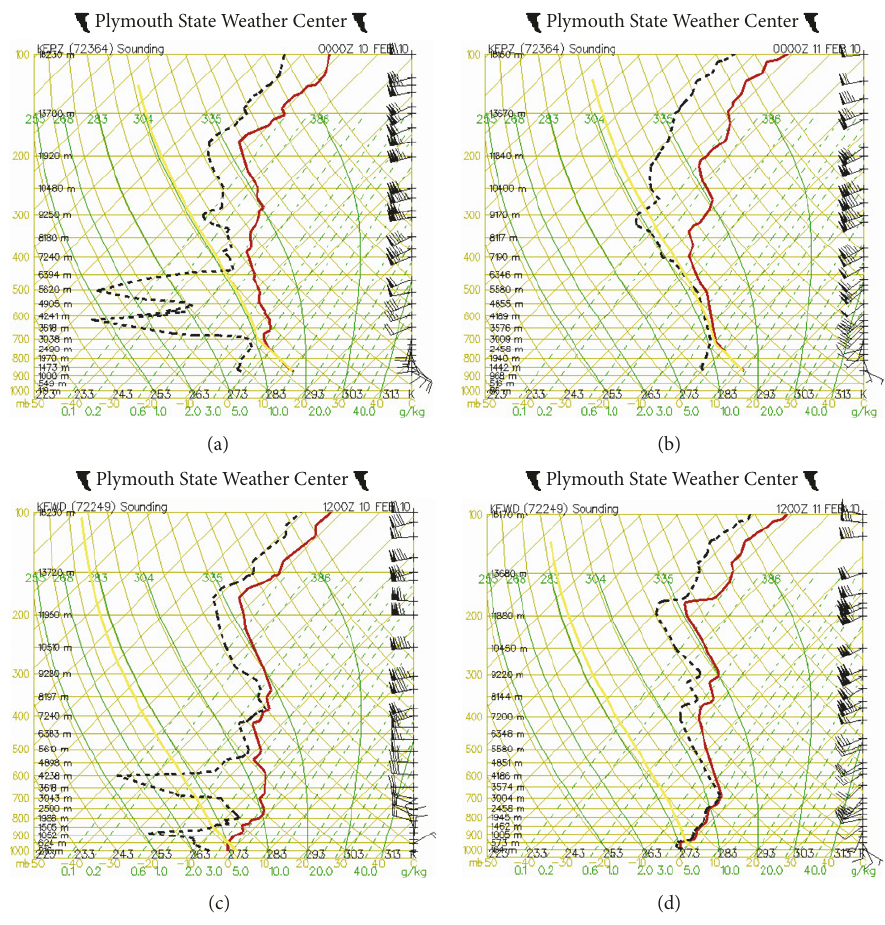
Figure 7: Plymouth State Weather Center radiosonde soundings for El Paso, Texas (EPZ) valid at (a, b) 0000 UTC 10 and 11 February and Dallas Fort-Worth, Texas (FWD), valid at (c, d) 1200 UTC 10 and 11 February 2010.